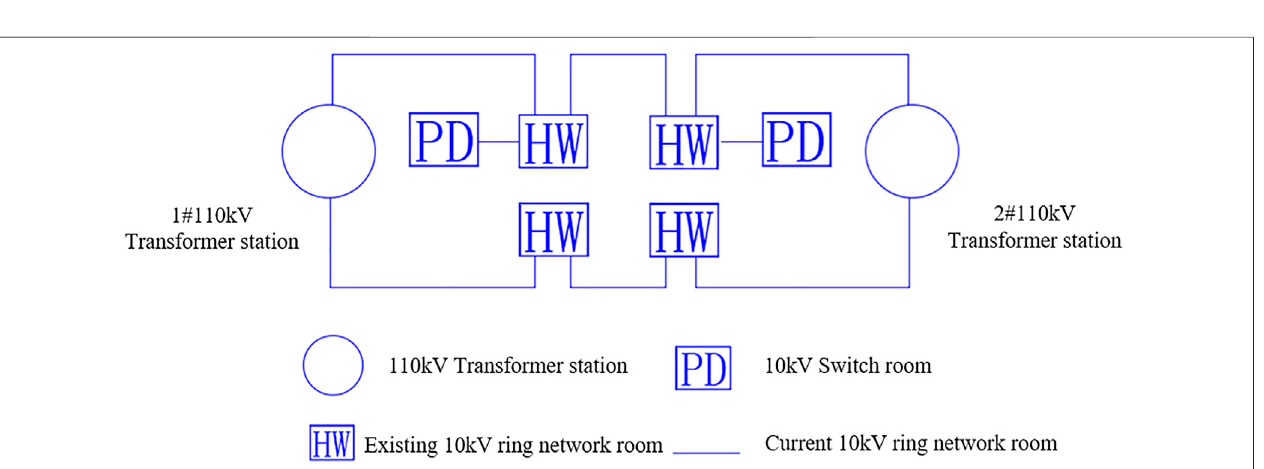
FIGURE 7 | Schematic diagram of the current distribution network wiring mode in the demonstration